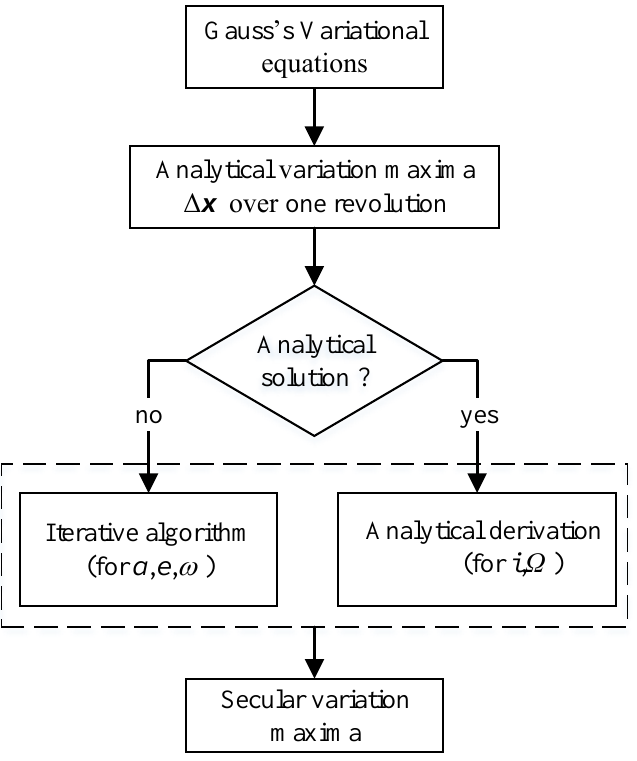
Figure 2. Procedure for approximating the secular variation